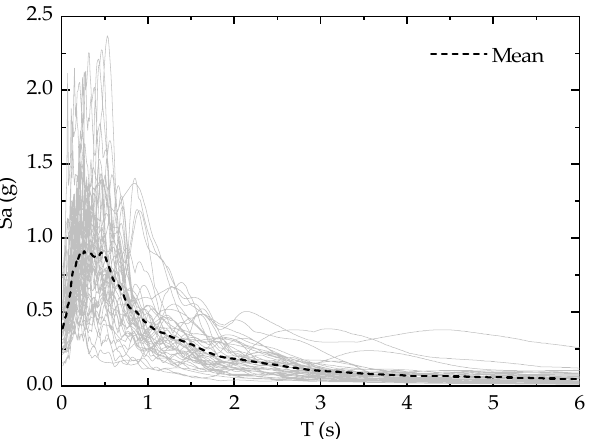
Figure 7. The acceleration spectra of the selected 44 ground motions.